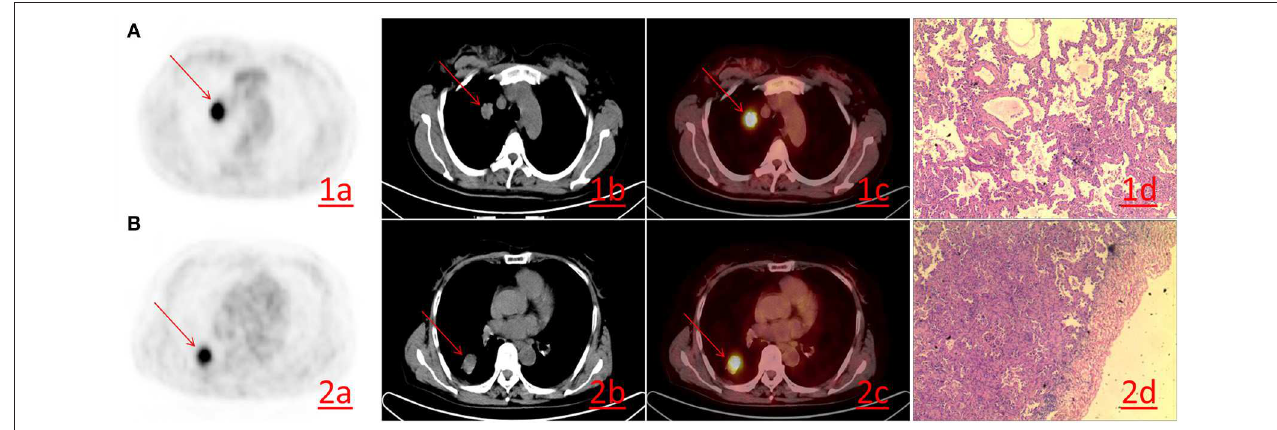
FIGURE 1 | (A) A 52-year-old female with lung adenocarcinoma of the right upper lobe. PET/CT revealing lung adenocarcinoma of the right upper lobe, ∼ 19 × 25mm in size, with increased FDG metabolism. The SUVmax was 10.20 (1a − 1c), Hematoxylin-eosin staining (1d) reveals the histological type of acinar predominant adenocarcinoma (HE × 200). (B) A 61-year-old female. PET/CT revealing lung adenocarcinoma of the right lower lobe, ∼ 31 × 25mm in size, FDG metabolism increased and SUVmax was 7.70 (2a − 2c). Hematoxylin-eosin staining (2d) reveals the histological type of papillary predominant adenocarcinoma (HE × 200).